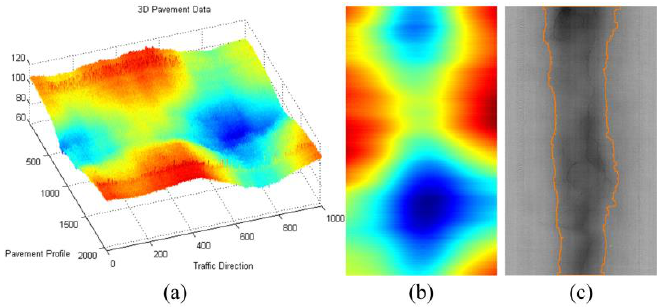
Figure 16. The low-frequency components and the corresponding pavement distresses information, ( a ) 3D pavement data, ( b ) corresponding low-frequency components, ( c ) rutting information.